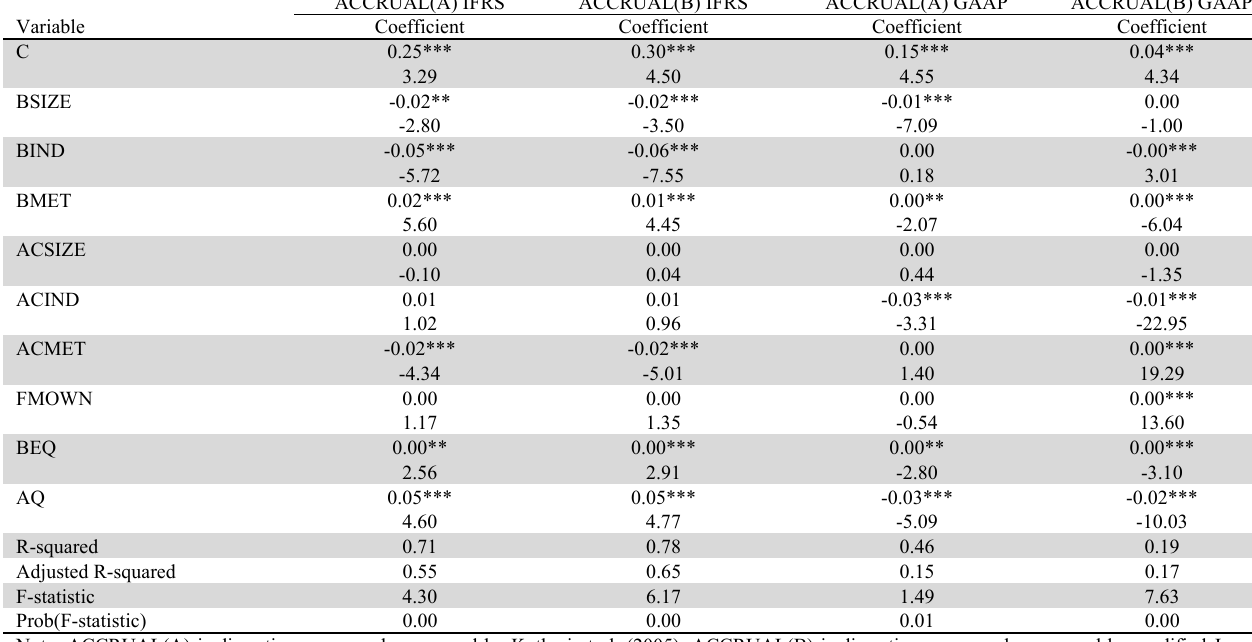
Regression Analysis of the impact of CG mechanisms on earning management Pre-Post-IFRS